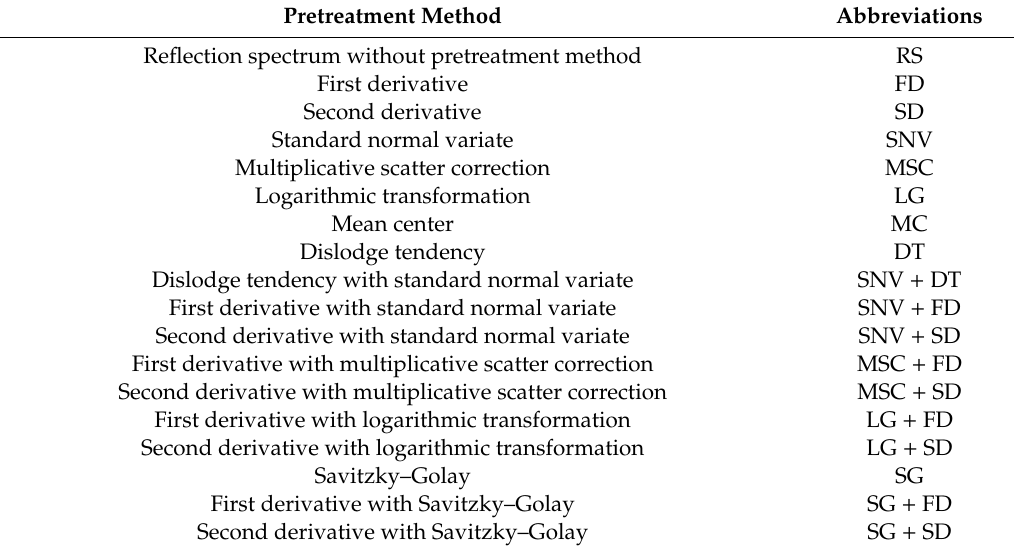
Table 1. Pretreatment methods applied to the visible near-infrared (VIS-NIR) of soil